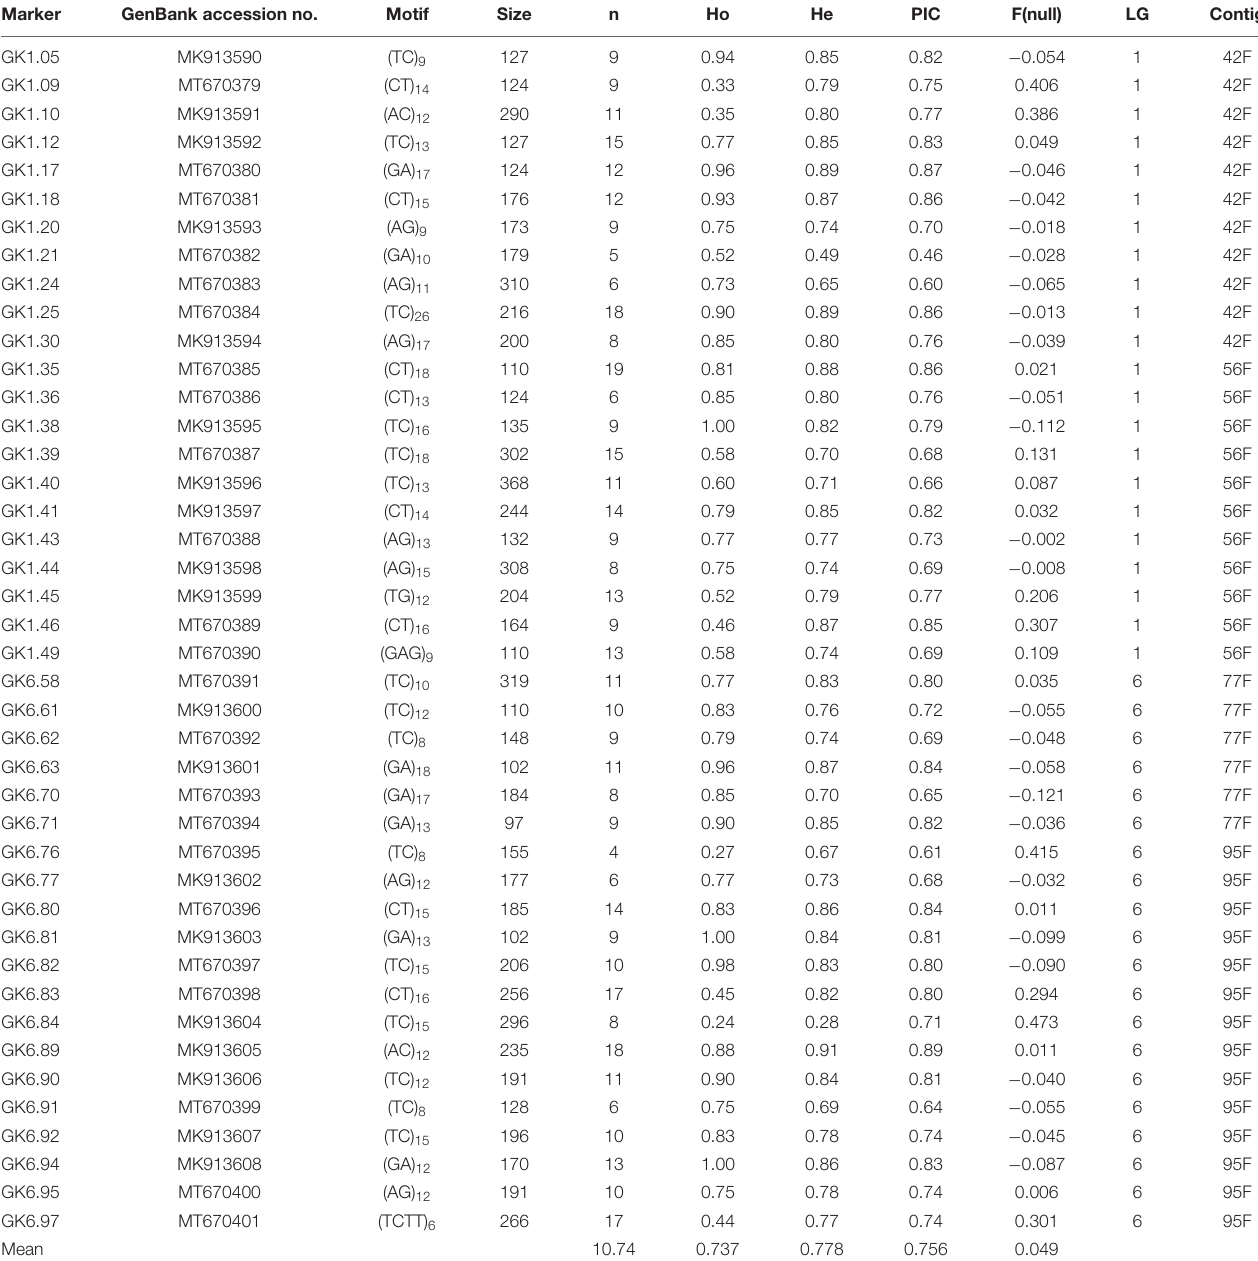
TABLE 4 | Characteristics of 42 new simple sequence repeat markers developed from four contigs in the V2 genome sequence of ’Jefferson’ hazelnut ( Corylus avellana ). Marker GenBank accession